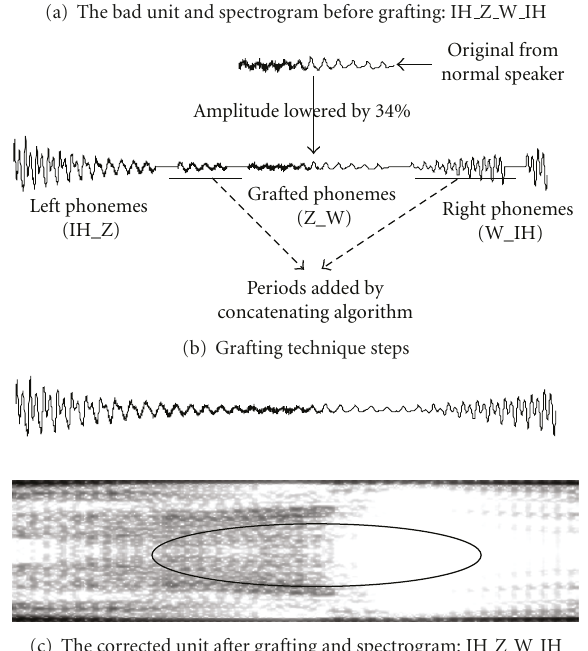
Figure 5: Grafting technique example correcting the unit